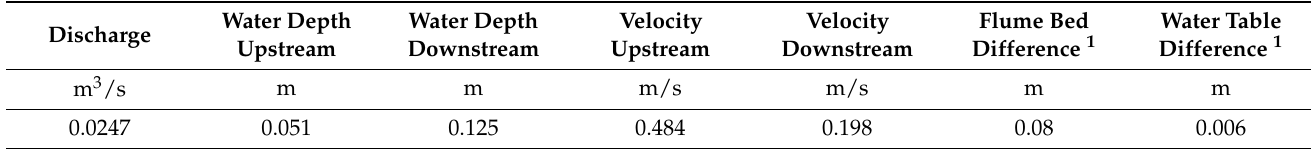
Table 2. Experiment